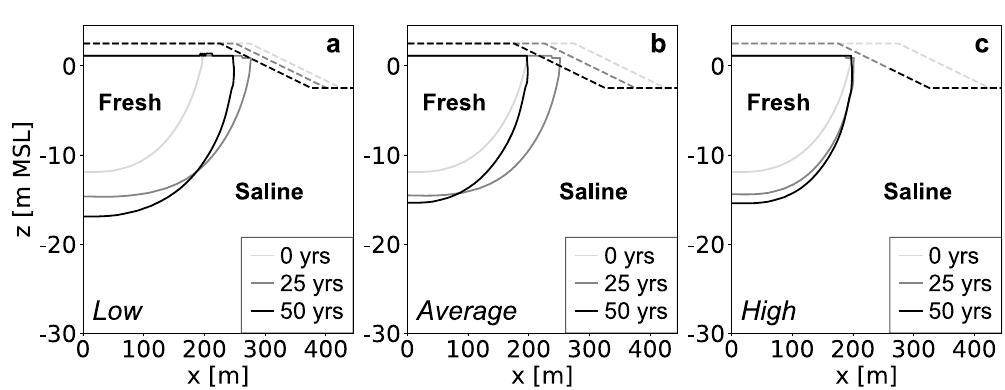
Figure 11. Simulated growth of the fresh groundwater lens for low (left), average (centre), and high (right) estimates of coastal erosion. All images show the fresh-salt groundwater interface of 1 g TDS L − 1 (solid lines) and the surface elevation (dashed lines) at the start (light grey), middle (dark grey) and end (black) of the simulation period.